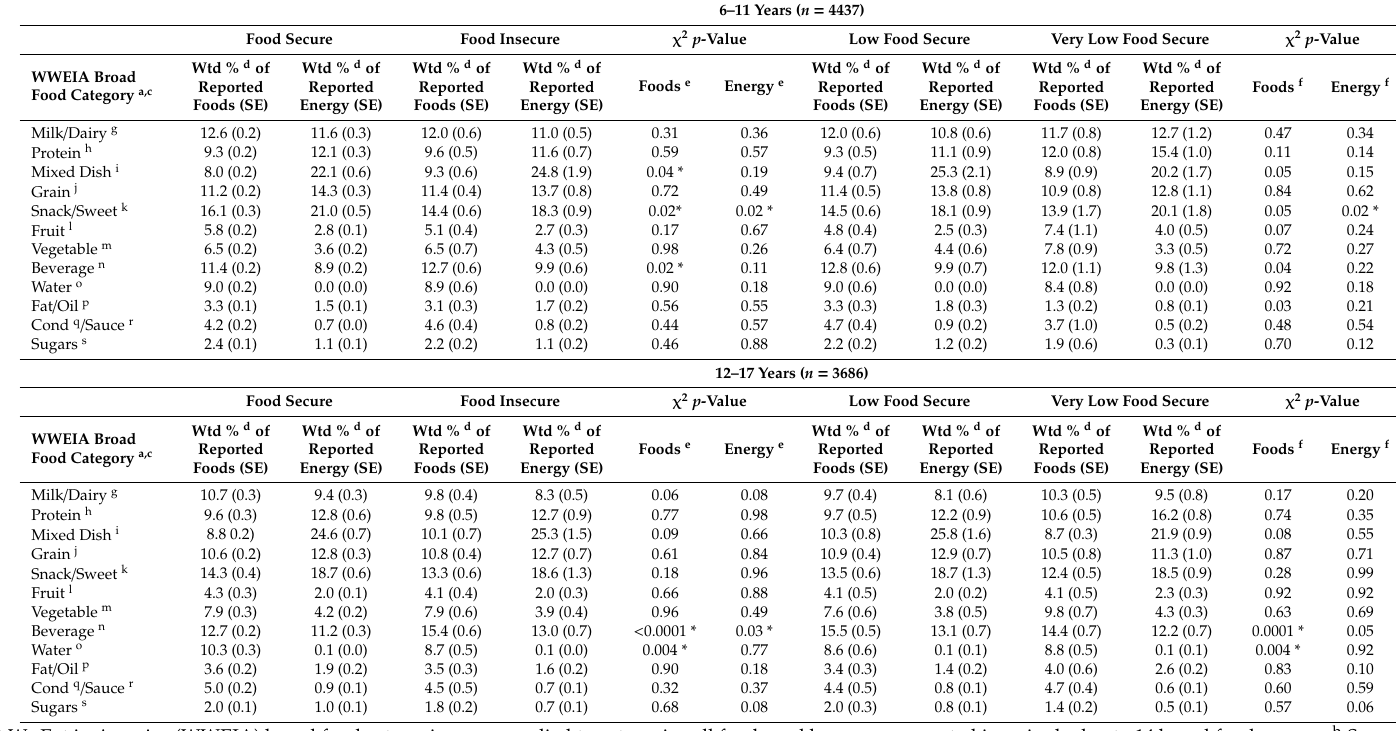
Table 2. What We Eat in America broad food category a intake comparisons by frequency and energy among food secure and insecure (low and very low food secure) U.S. children and adolescents 6–11 and 12–17 years using the National Health and Nutrition Examination Survey 2007–2014 b